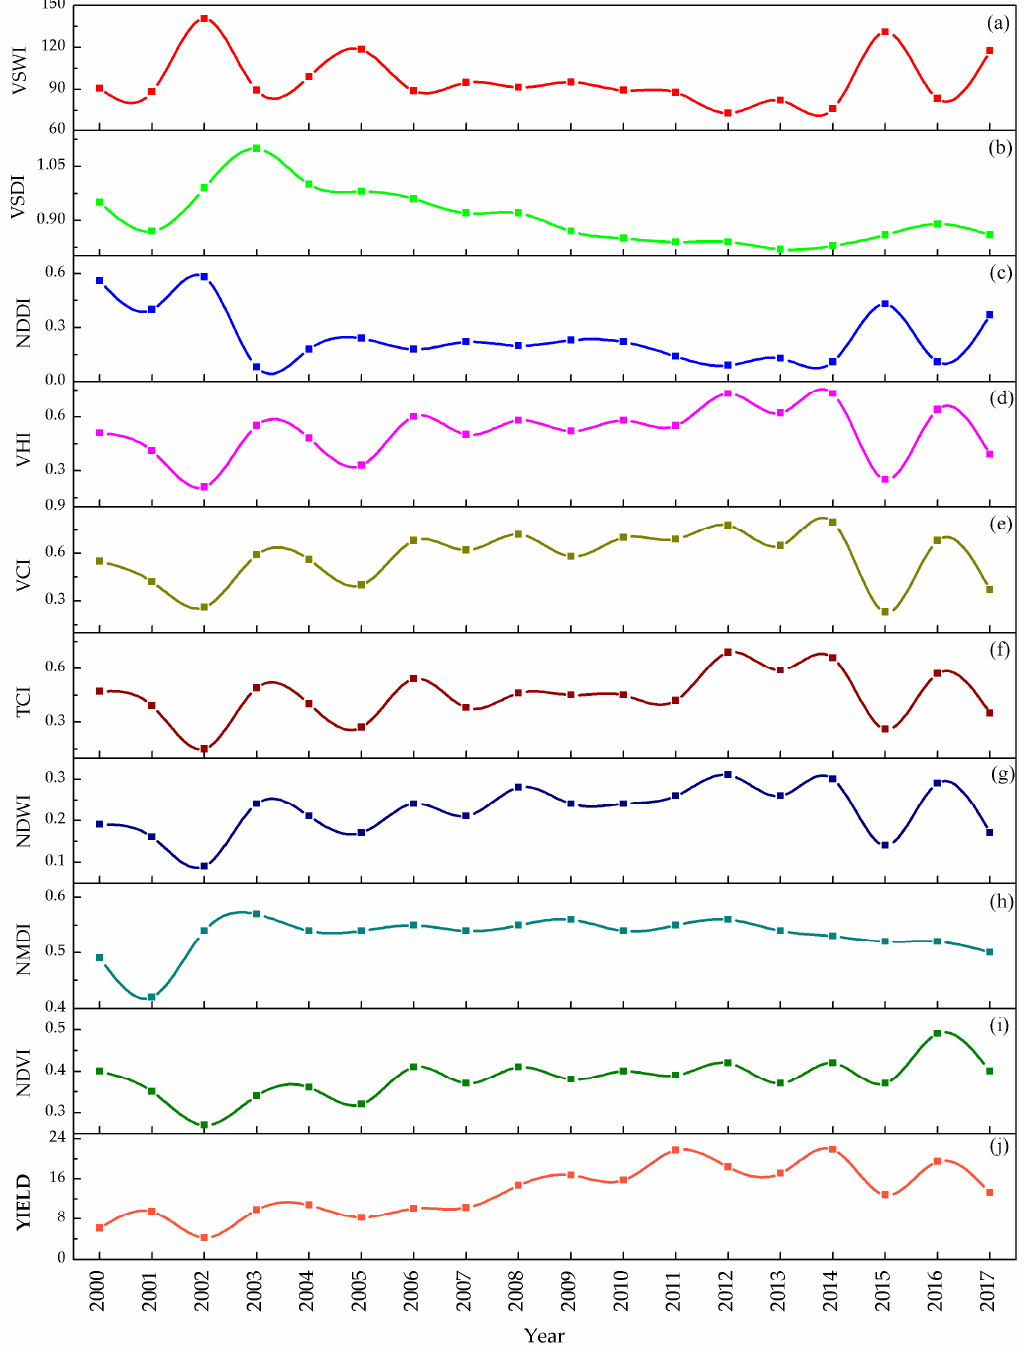
Figure 6. Annual growth season (June–August) average VSWI ( a ), VSDI ( b ), NDDI ( c ), VHI ( d ), VCI ( e ), TCI ( f ), NDWI ( g ), NMDI ( h ), NDVI ( i ), and Spring wheat yield ( j